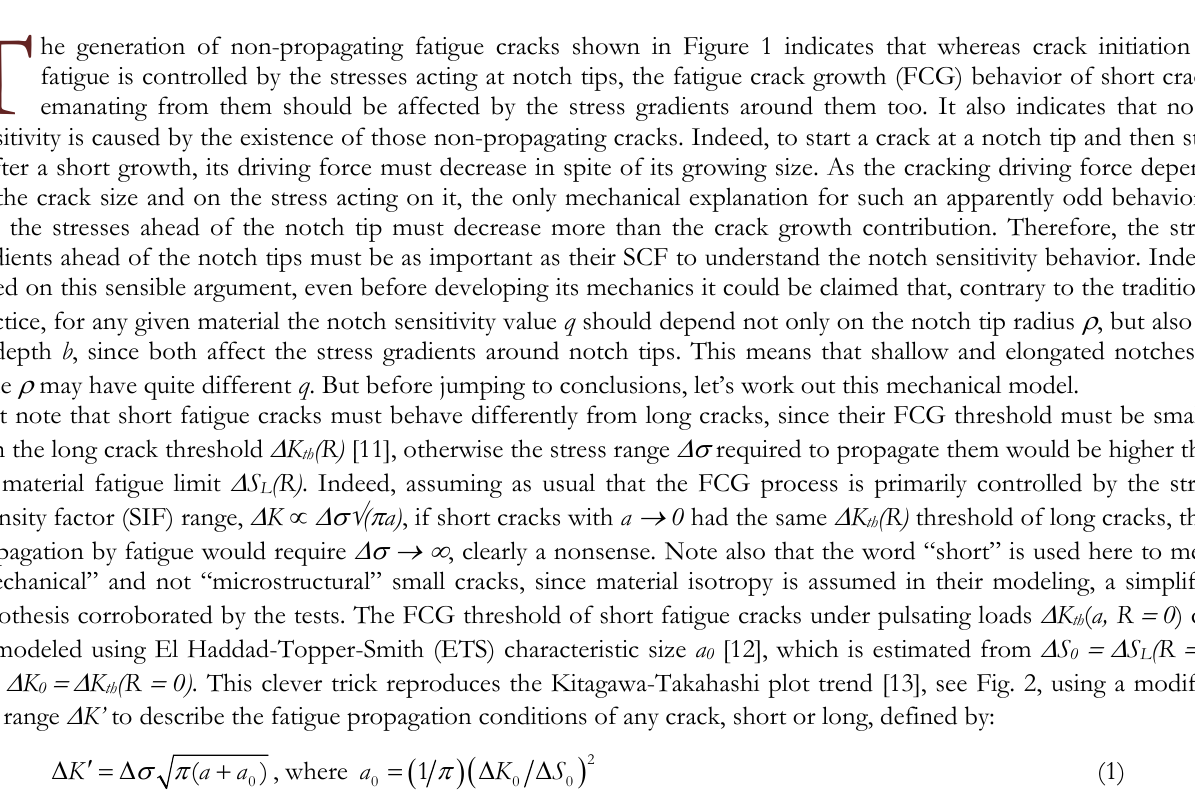
A NALYSIS OF N OTCH E FFECTS ON THE FCG B EHAVIOR OF S HORT C